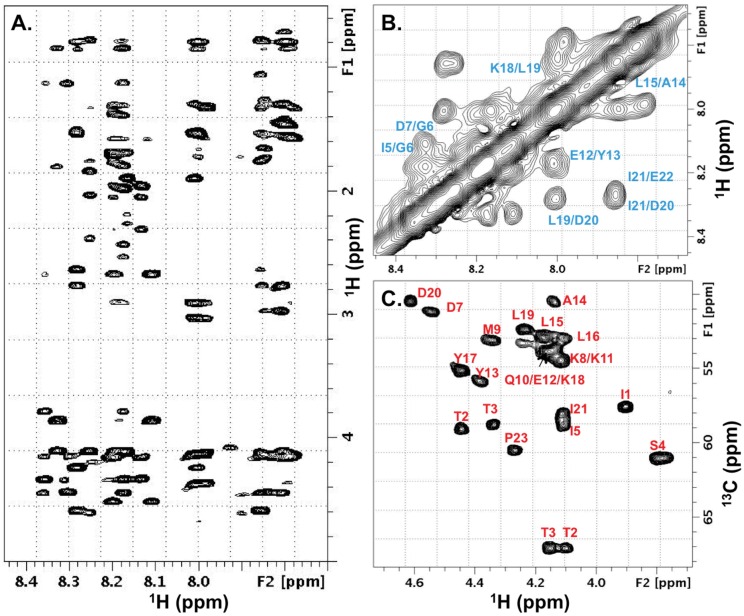
NMR structural analysis of HIV V2 MN peptide supports a propensity for alpha-helical structure.(A) Representative amide proton to side-chain correlations from a 2D homonuclear NOESY spectrum, (B) Inter-residue HN-HN correlations from 2D NOESY, and (C) 2D natural abundance C13-edited HSQC spectrum of the Calpha region. The residue specific annotations are displayed in panels (B) and (C).